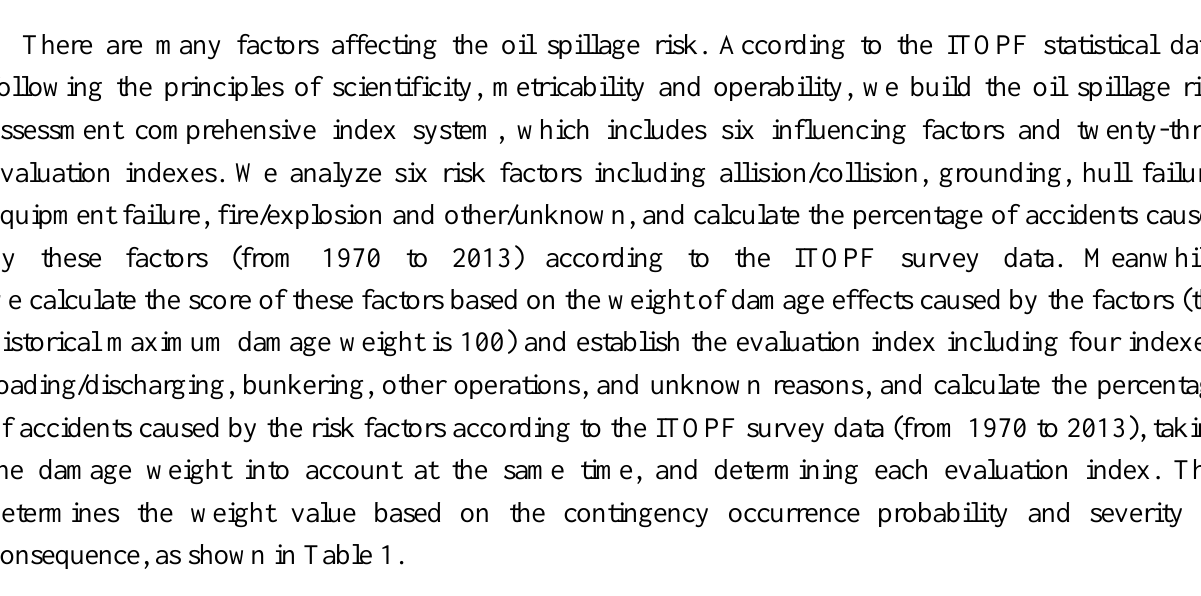
Table 1. The oil spillage risk assessment index